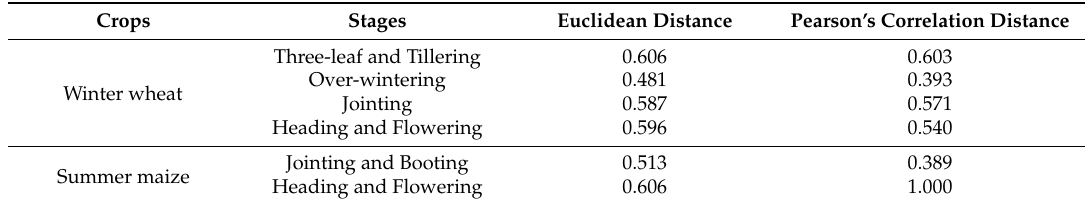
Figure 7. Landsat NDVI time series images from 2000–2001 of Erlitou. Winter wheat: ( a ) Tillering (22 November 2000); ( b ) Over-wintering (26 January 2001); ( c ) Jointing (30 March 2001); ( d ) Heading (16 April 2001); ( e ) Flowering (10 May 2001). Summer maize: ( f ) Jointing (12 July 2001); ( g ) Heading (22 August 2001); ( h ) Flowering (6 September 2001). The negative crop anomalies caused by palace bases No. 5 and No. 3, the ancient road and the eastern wall of the imperial palace can be identified in images ( c – e ) and ( g ) and ( h ), and the sacrificial area also shows negative anomalies in images ( c – e ). Table 4. Distance measurement results for Erlitou site.